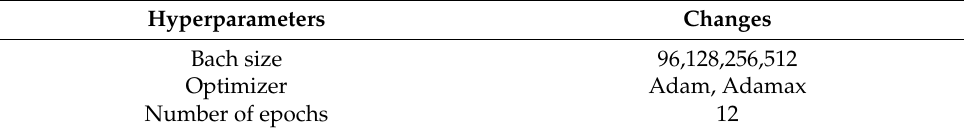
Table 3. Hiperparameters used in this